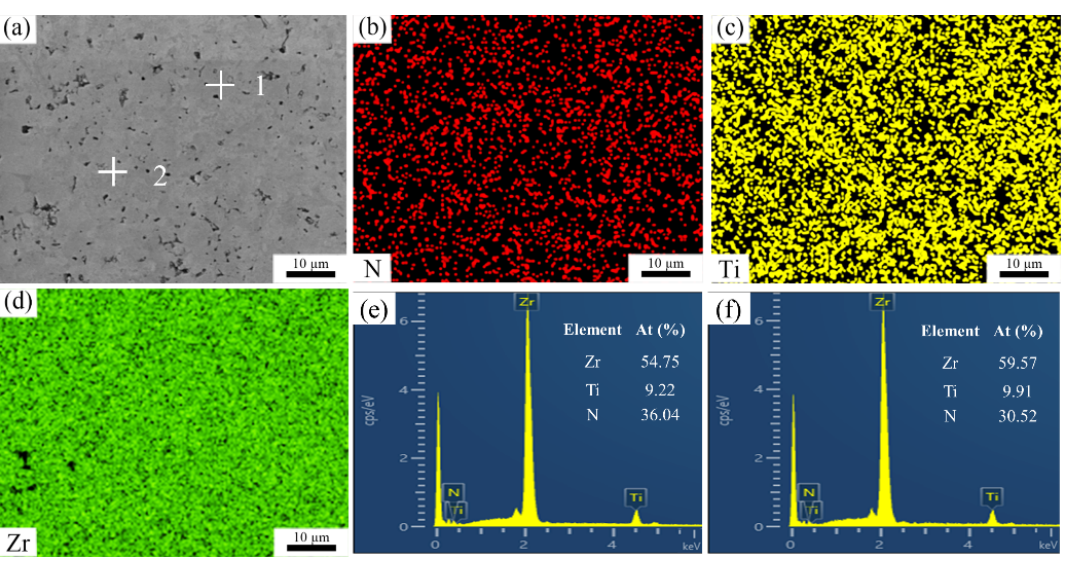
Figure 4. ( a ) BSE image of sample ZT10, ( b )–( d ) EDS mapping of N, Ti, and Zr, ( e ) and ( f ) EDS spectra of spots 1 and 2, respectively.